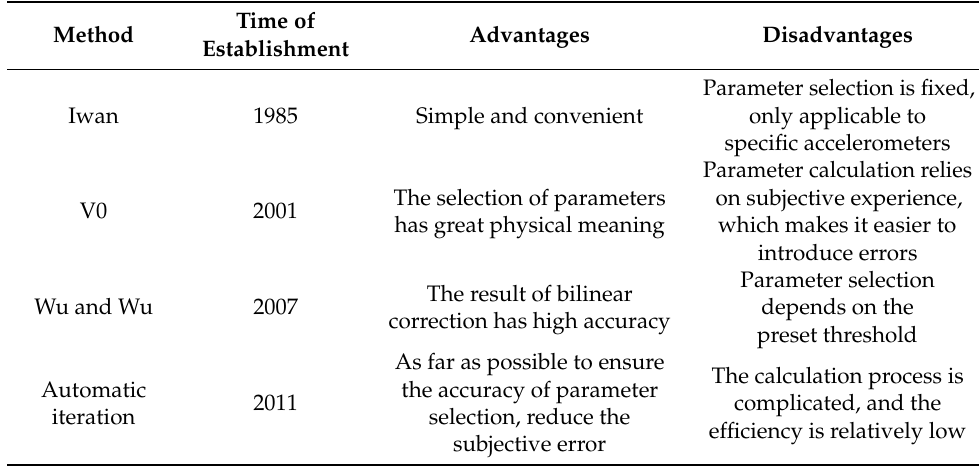
Table 1. Summary of baseline correction